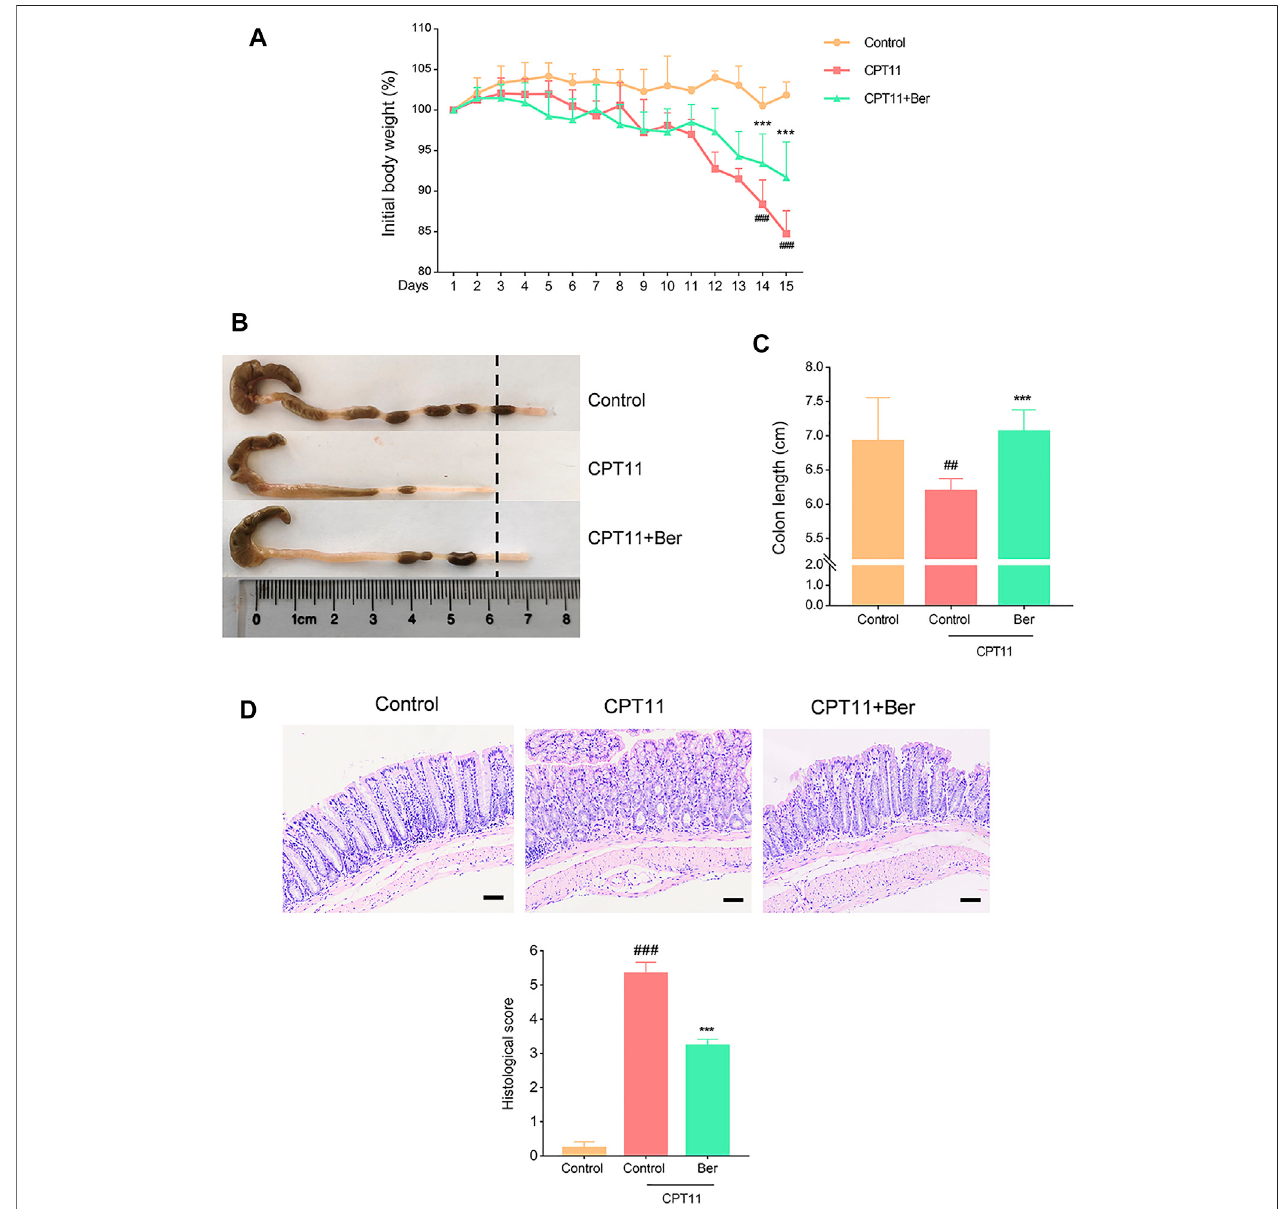
FIGURE1| Berberine ameliorated body weight loss, colon shortening, and histopathologic injury, in mice with CPT11-induced intestinal mucositis. (A) Changes in body weight in mice with CPT11-induced mucositis. The data are plotted as a percentage of the original body weight. Macroscopic observations (B) and the assessment of colon shortening (C) after berberine treatment. (D) Representative H&E-stained colon sections and histological scores. Scale bars correspond to 50 μ m. Data are expressed as the mean ± SD ( n (cid:2) 6 per group). ## p < 0.01 vs. the control group; *** p < 0.001 vs . CPT11-treated